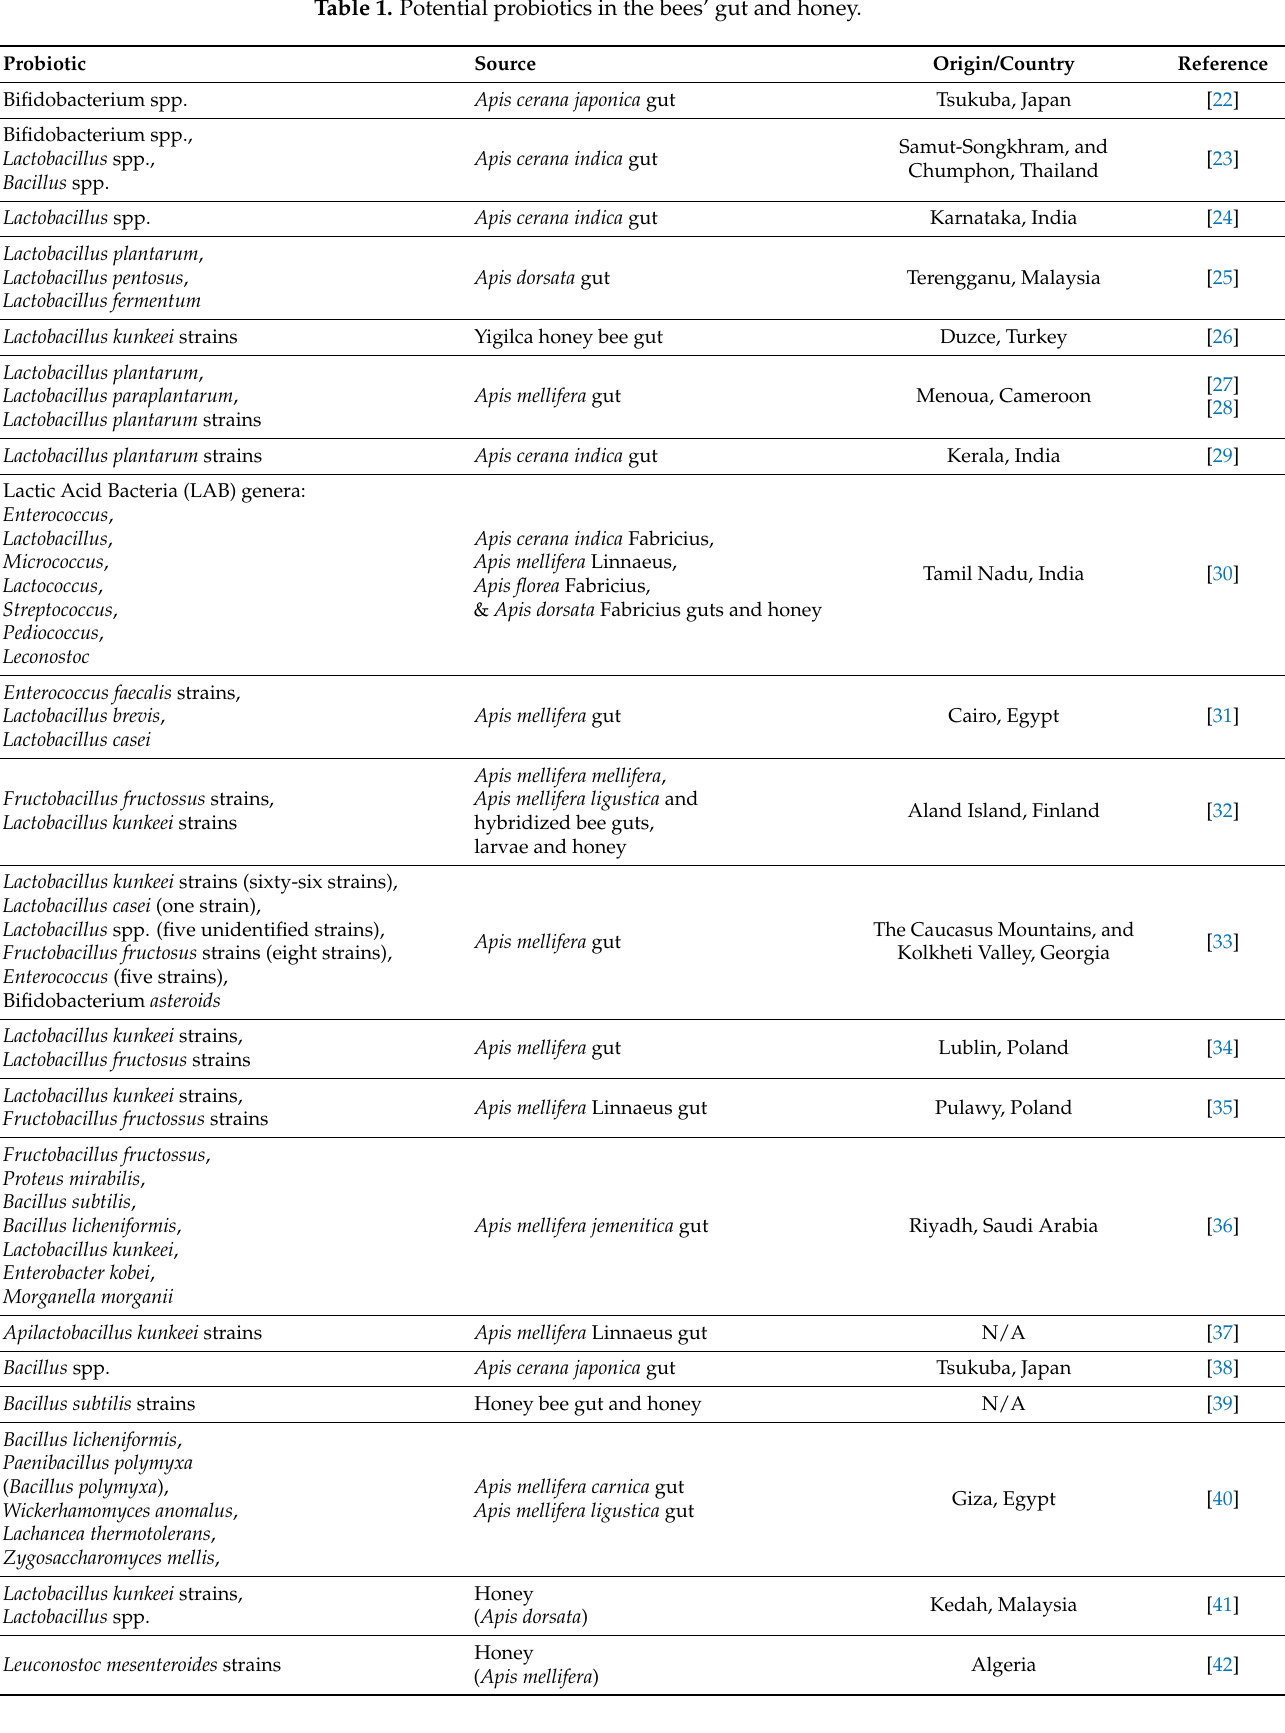
Table 1. Potential probiotics in the bees’ gut and